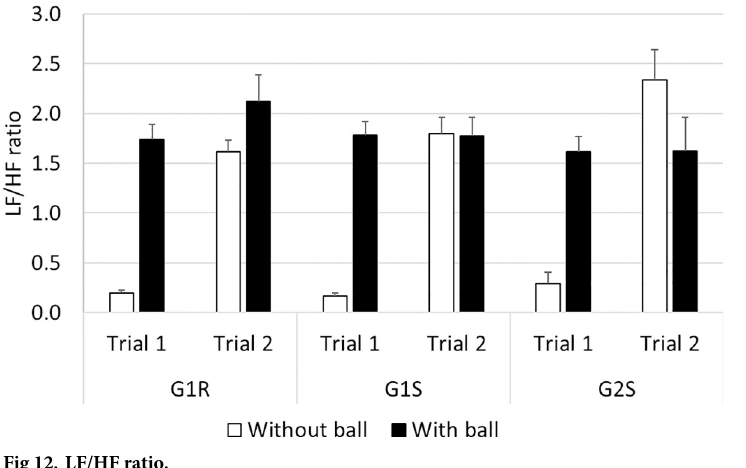
Fig 12. LF/HF ratio.